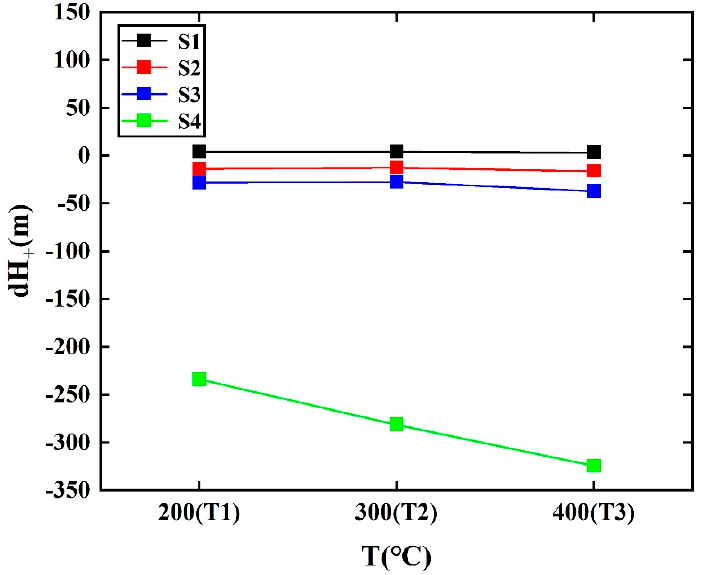
Figure 7. The rising height difference (dH + ) between the moving source scheme and the stationary source scheme at different emission temperatures in the V2 scenario with a wind speed of 3 m/s.